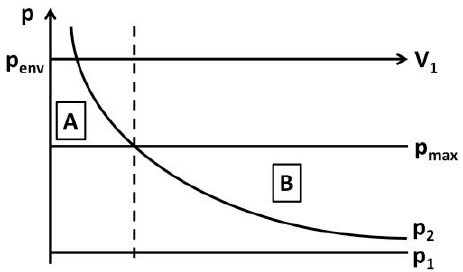
Figure 3. The figure shows the estimation of the point of change in the bubble formation